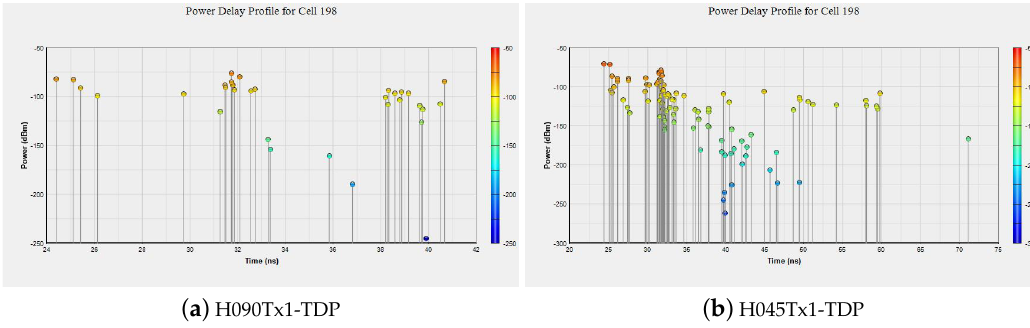
Figure 5. Time delay profile vs. antenna polarization, H090 and